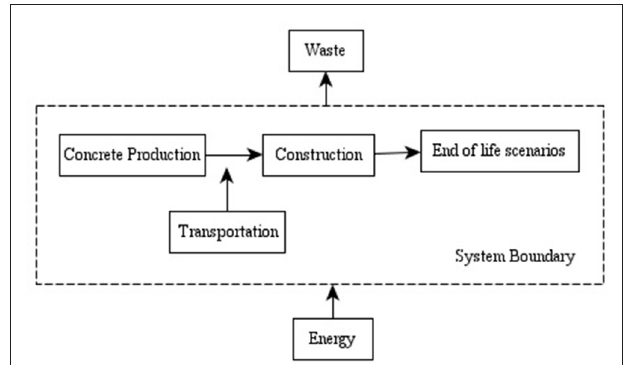
FIGURE 1 | System boundary of the